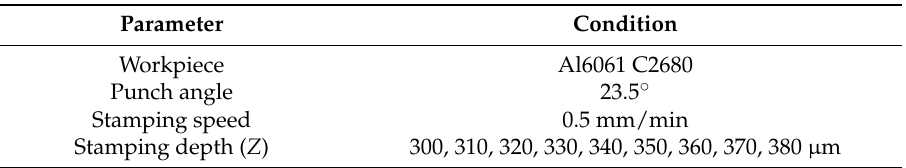
Table 2. Micro stamping parameters.